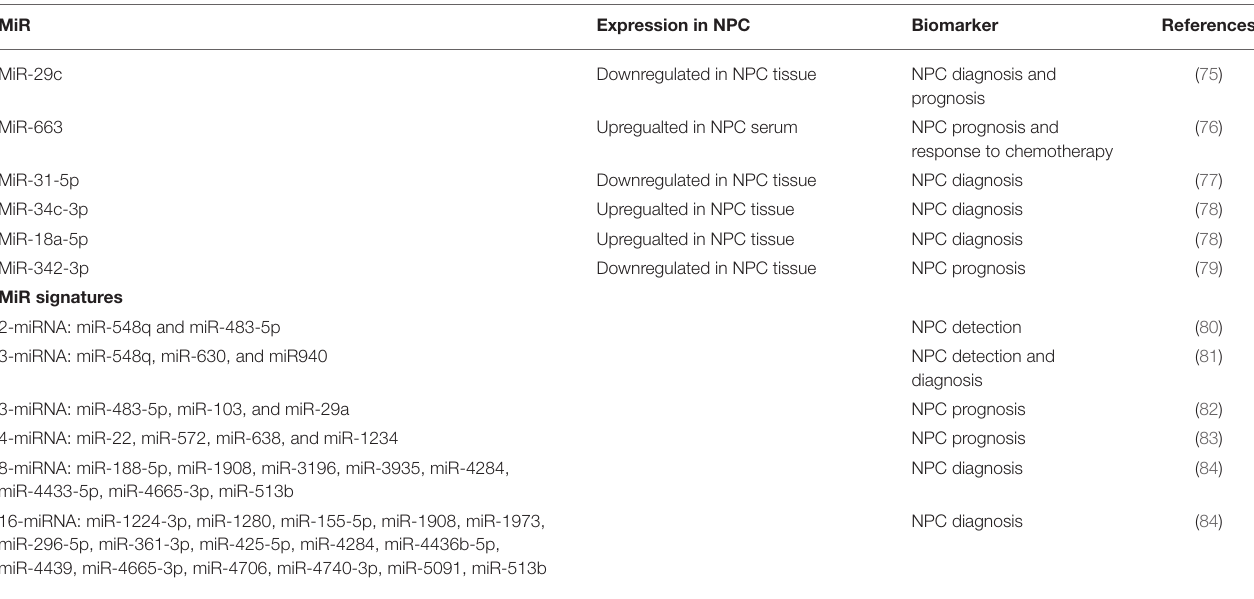
TABLE 2 | miRNAs as biomarkers in NPC.